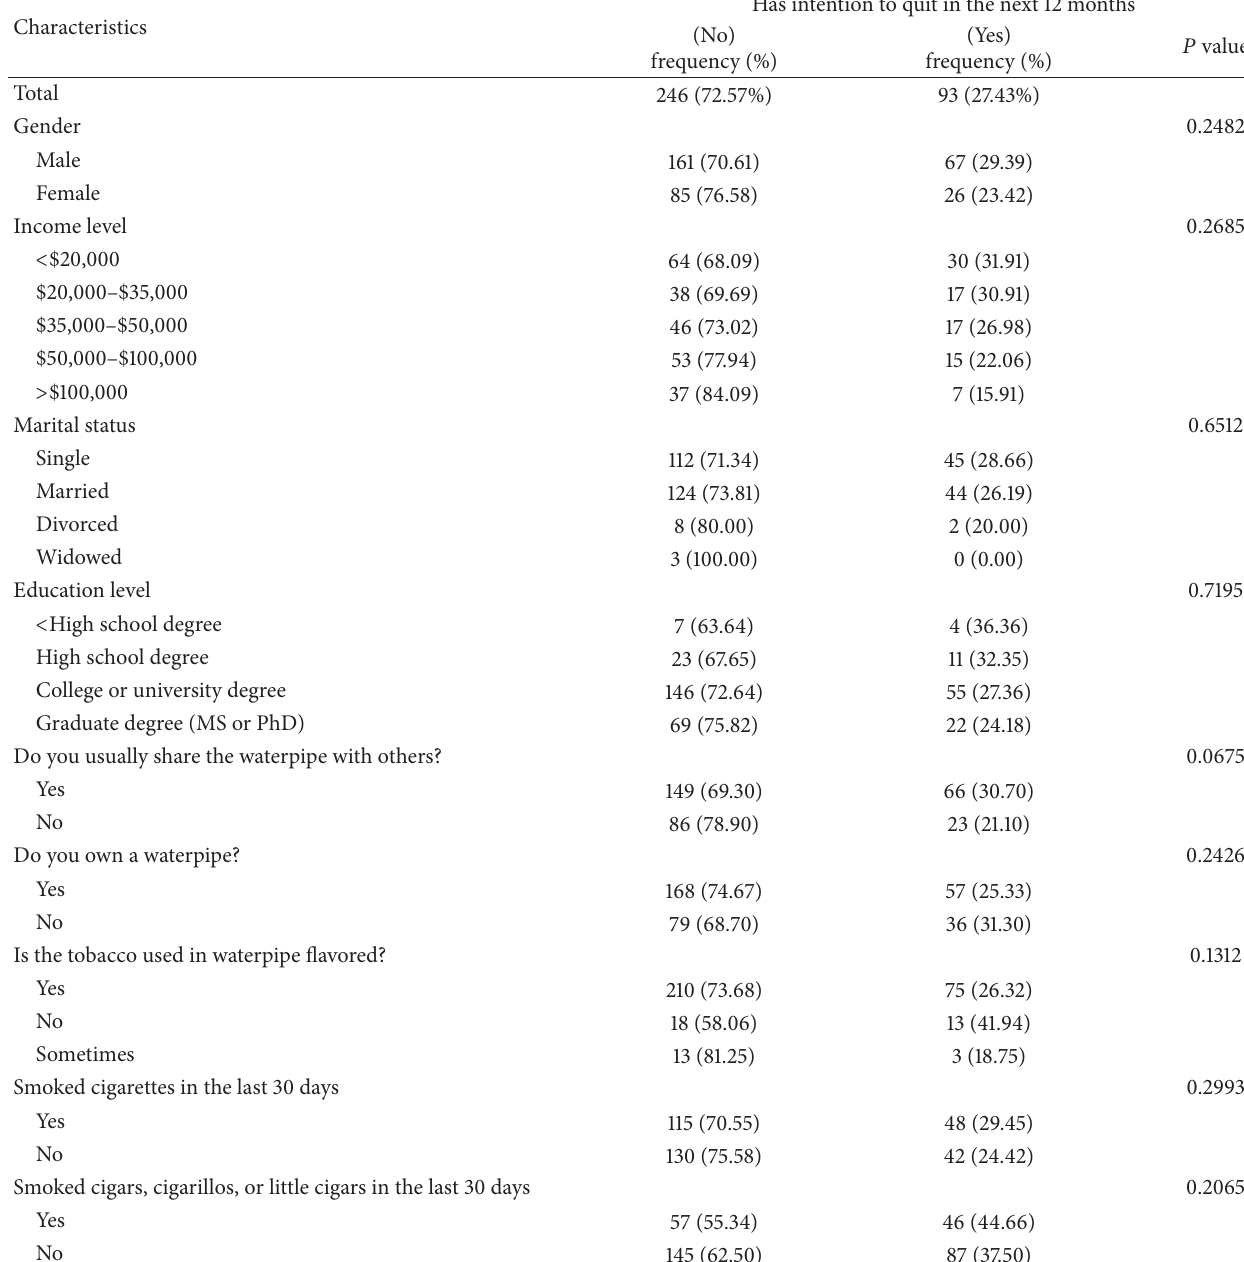
Table 1: Frequency of intention to quit waterpipe smoking by sample